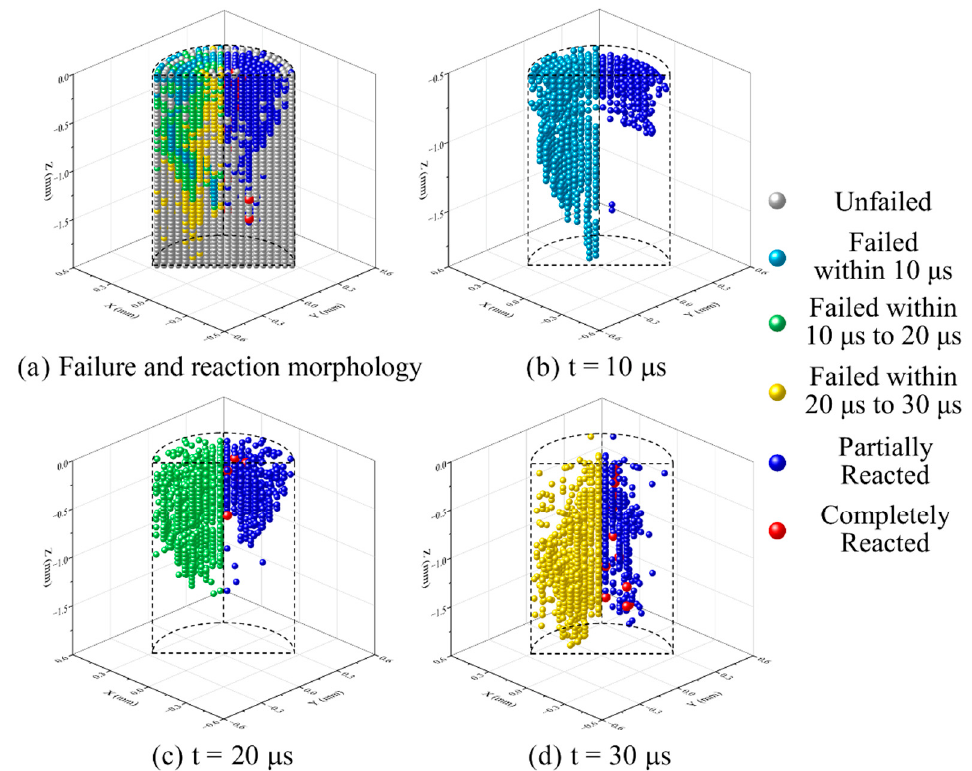
Figure 10. Failure and reaction morphology of the front third part of RM rod of 775 m/s impact velocity at different times: ( a ) overall failure image at 30 μ s and corresponding reaction morphology at 60 μ s; ( b ) particles failed within 10 μ s; ( c ) particles failed within 10 μ s to 20 μ s; ( d ) particles failed within 20 μ s to 30 μ s.